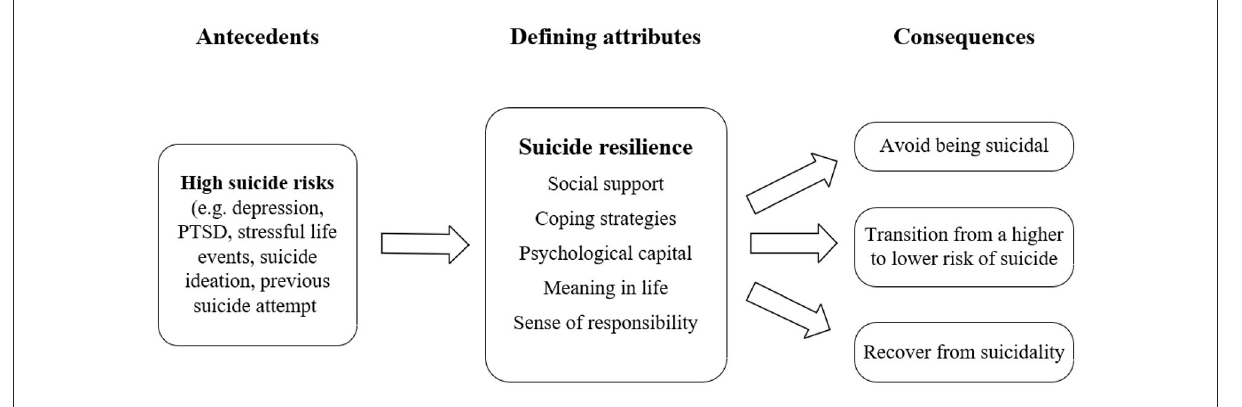
FIGURE2 Conceptual model of suicide resilience[[Inline